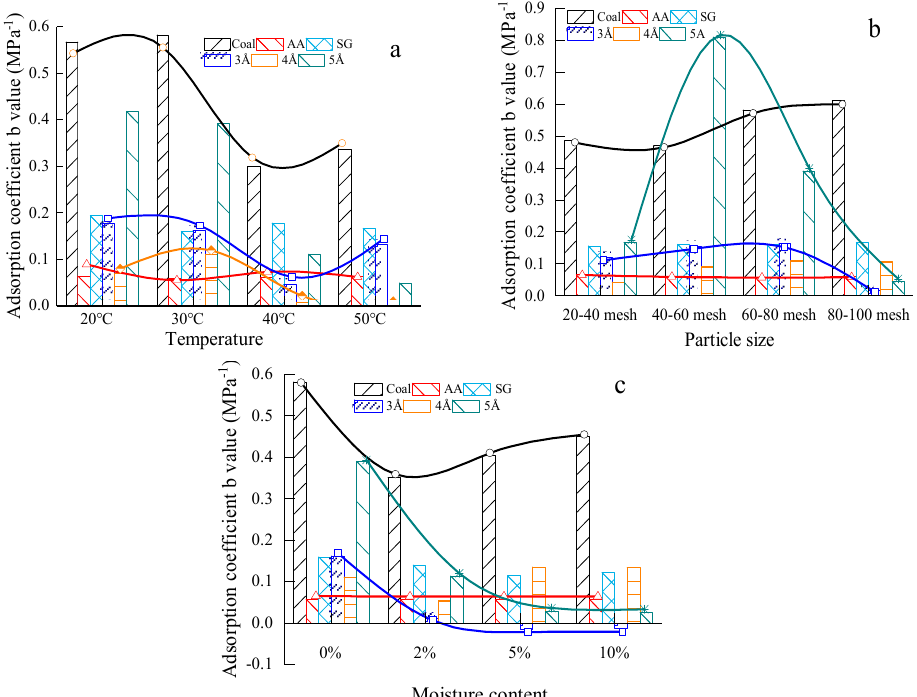
different moisture contents.